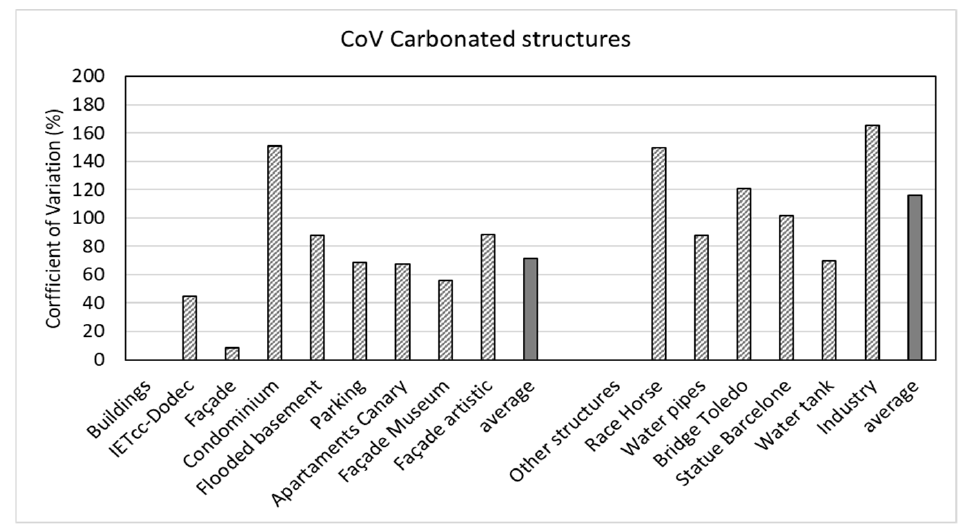
Figure 6. Average values of the coefficient of variation in different carbonated structures.